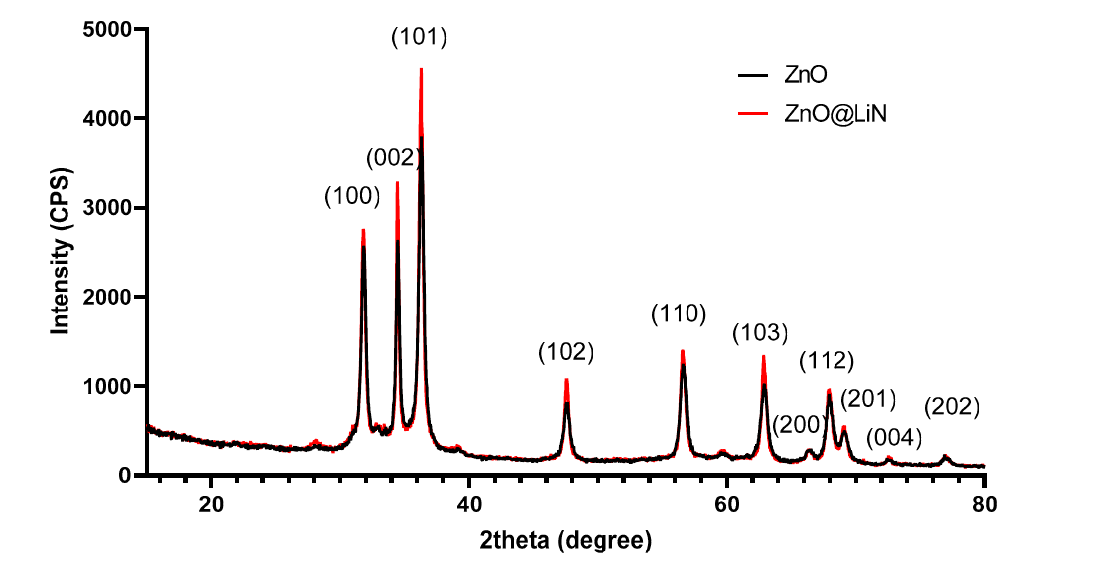
Figure 1. Diffractogram of ZnO NPs and ZnO@LiN NPs.